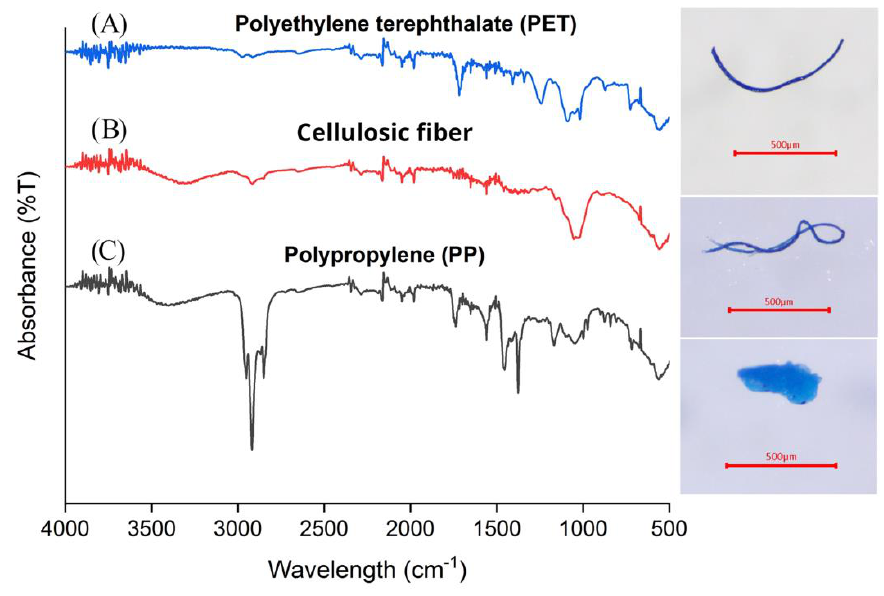
Figure 5 . Three types of polymers analyzed by FTIR include : ( A ) PET; ( B ) Cellulosic fiber; and ( C ) PP found in all three organs studied in O . militaris .